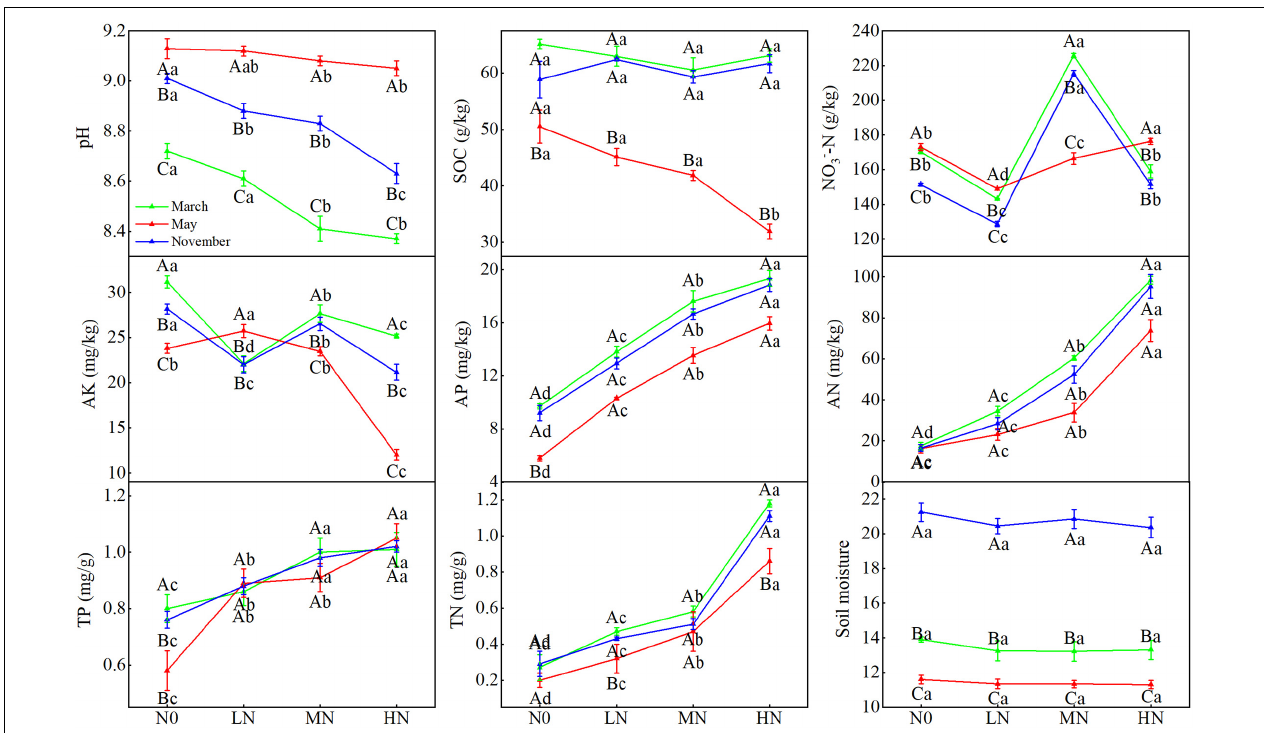
FIGURE 1 | Seasonal changes in soil physicochemical properties in moss crust soil with different levels of N additions. N0 = 0 g N m - 2 year - 1 ; LN = 1.8 g N m - 2 year - 1 ; MN = 3.6 g N m - 2 year - 1 ; HN = 7.2 g N m - 2 year - 1 . Different capital letters indicate a significant difference among the three sampling months with the same concentration; different lowercase letters indicate a significant difference among four N treatments in the same sampling month. Vertical bars show the standard error (SE) ( n = 3).